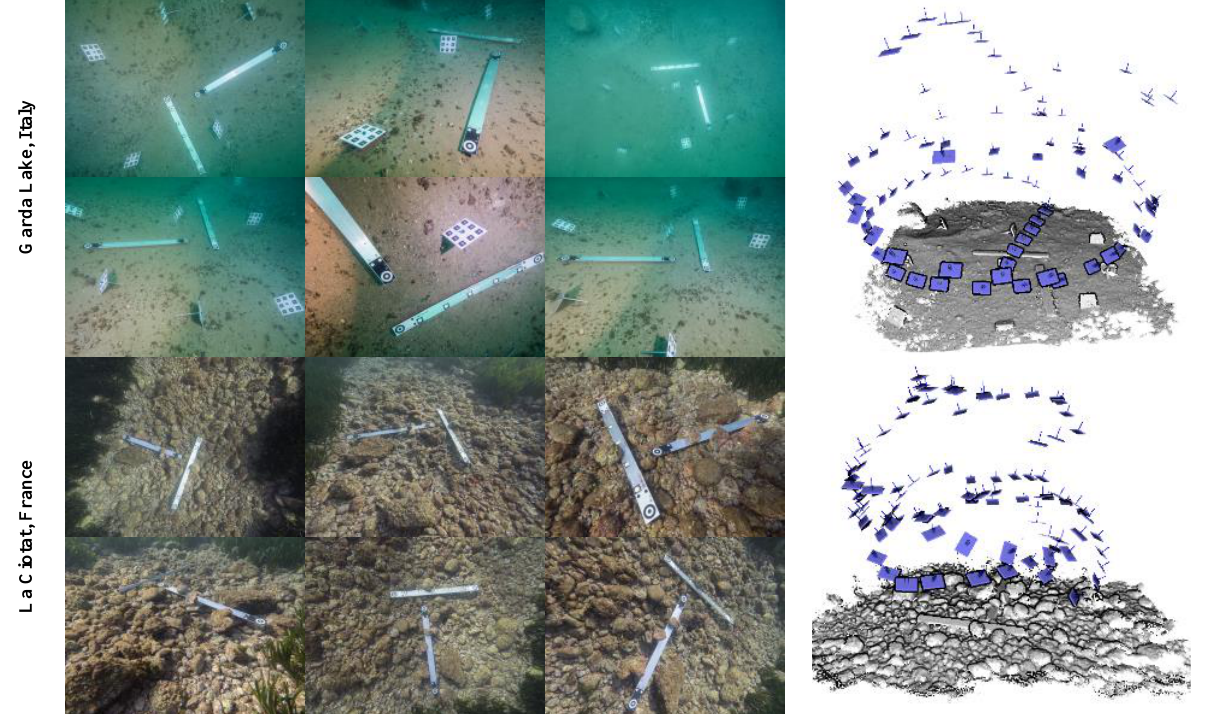
Figure 5 . Image datasets captured respectively in the lake (upper row) and at sea (lower row) to test the developed scaling and levelling procedure based on hydrostatic pressure measurements. The camera network is shown in the right column.